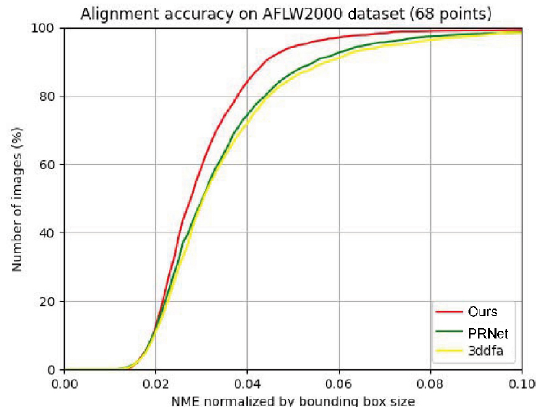
Fig. 11 Cumulative error distribution curves of 3D face alignment accuracy on the ALFW2000 dataset. Compared with PRNet [73], and 3ddfa [7], our method produces better results.